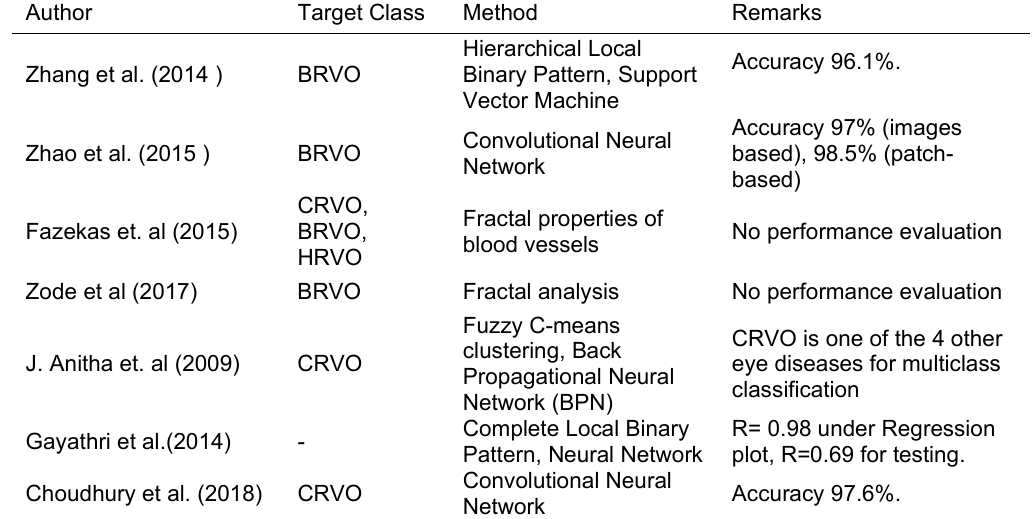
Table 3. State-of-the-Art of RVO Detection